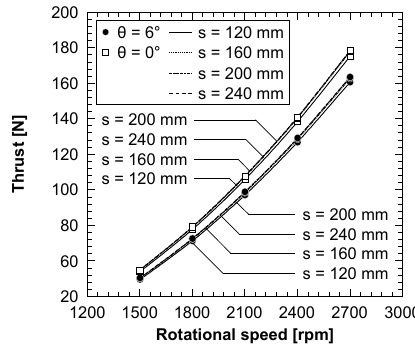
Figure 7. Thrust for different rotor spacings and duct diffusion angles.